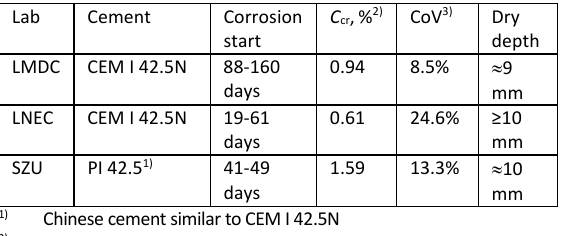
Table 1. Results from these three laboratories observed